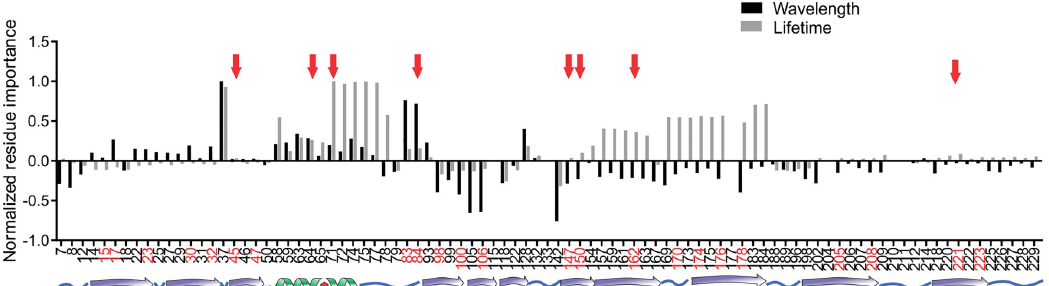
Fig 3. Residue importance for determining fluorescence lifetime (grey bars) or on peak emission wavelength (black bars) scaled as a proportion of the maximum importance for each property. Positive numbers indicate that the residue is of relative importance and negative values mean the residue is not important. Numbers on the x-axis correspond to residue number in mCardinal. The secondary structure of the protein is illustrated along the bottom of the graph. Residues 58–79 make up the alpha helix and loop that hold the chromophore (Red pentagon) inside the β -barrel. Numbers highlighted in red indicated those residues on the β -sheet or loop regions that face inside the β -barrel and thus, could interact with the chromophore. Red arrows indicate residues that were independently selected for the site-directed mutagenesis in mCardinal or